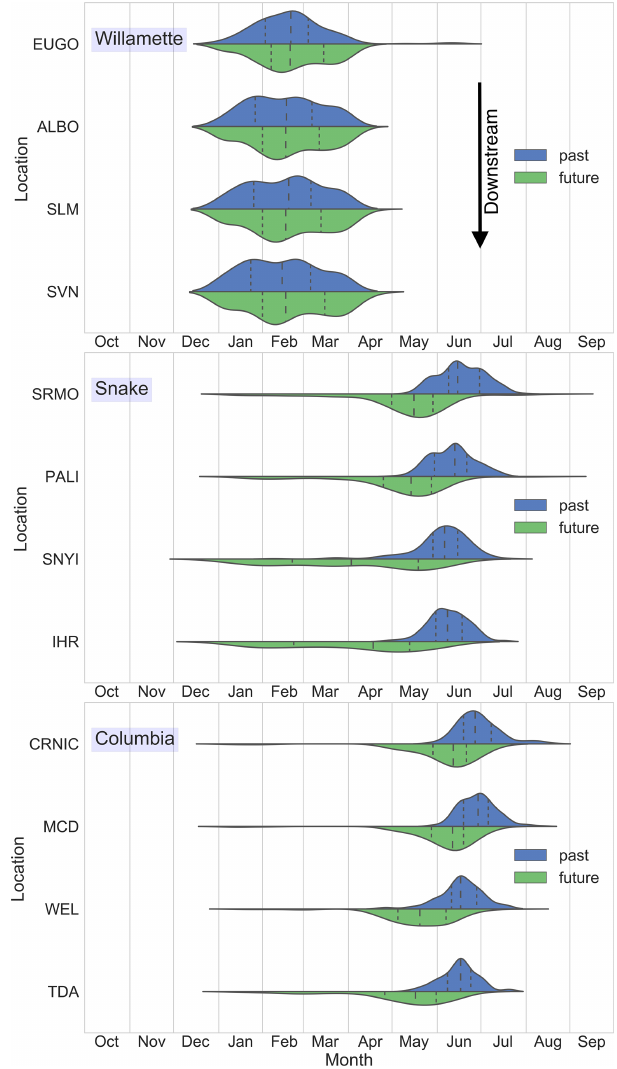
Figure 11. Statistical representations of the variation through the water year of the timing of flood events. For each of the 40 simu- lations, the dates of the five highest streamflows in the 50-year past (blue) and future (green) windows are tallied, and the resulting dis- tributions smoothed. Long dashed lines indicate median date; short dashed lines indicate the lowest and highest